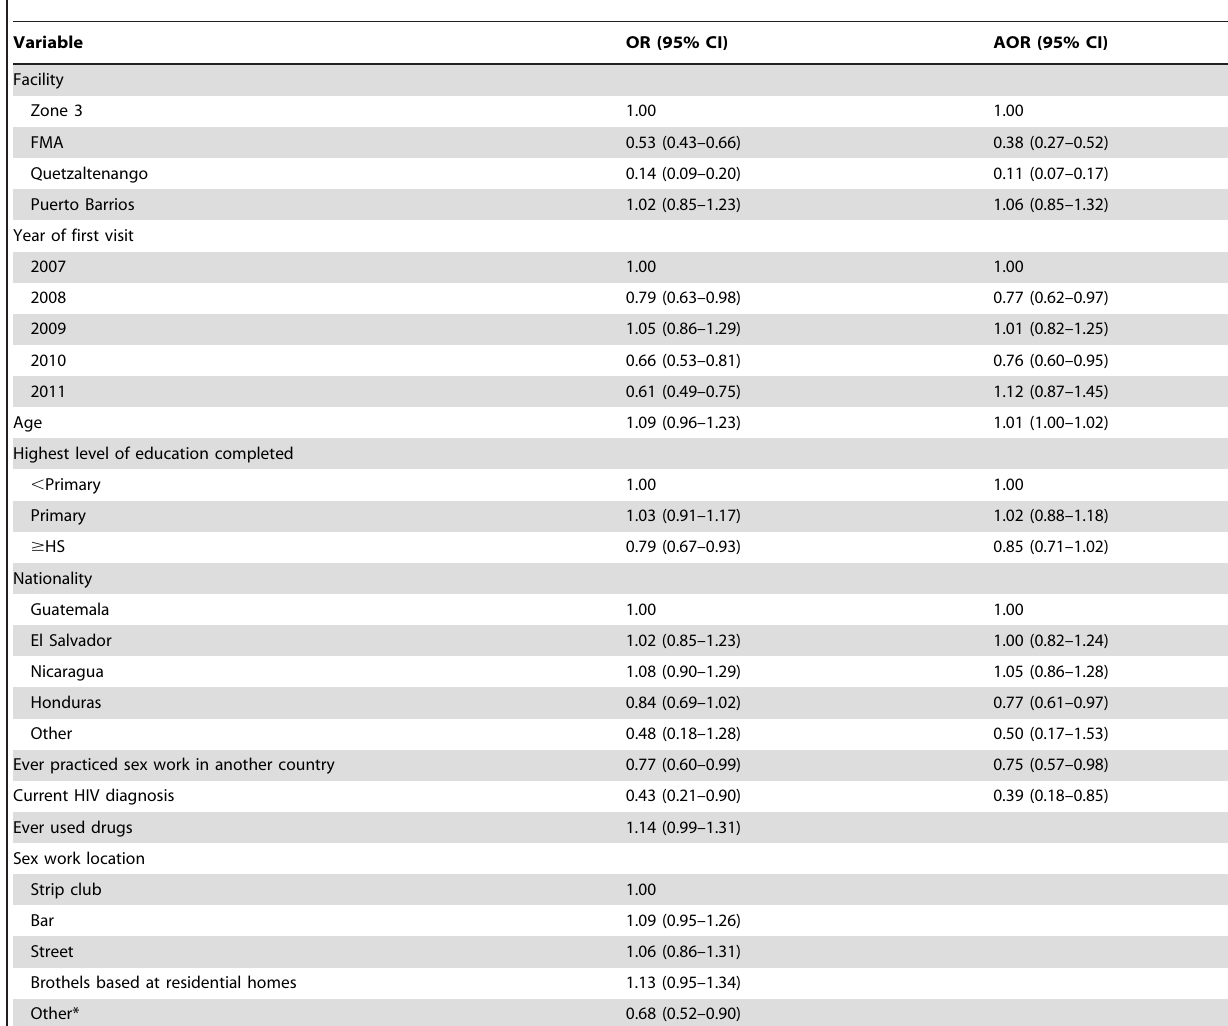
Table 5. Factors associated with retention among FSW attending VICITS clinics for the first-time, Guatemala, 2007–2011 (N=